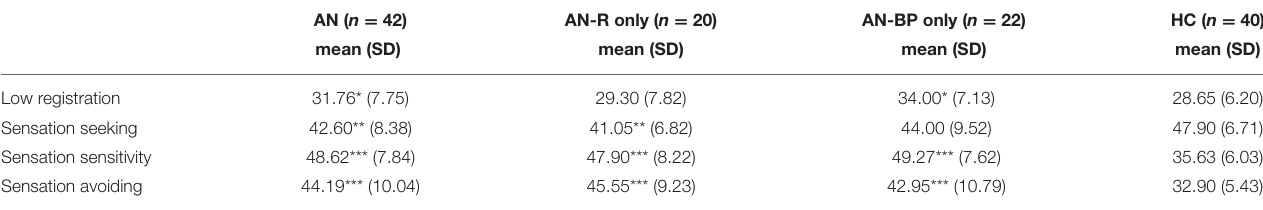
TABLE 2 | Means and standard deviations of sensory processing dimensions are presented in the